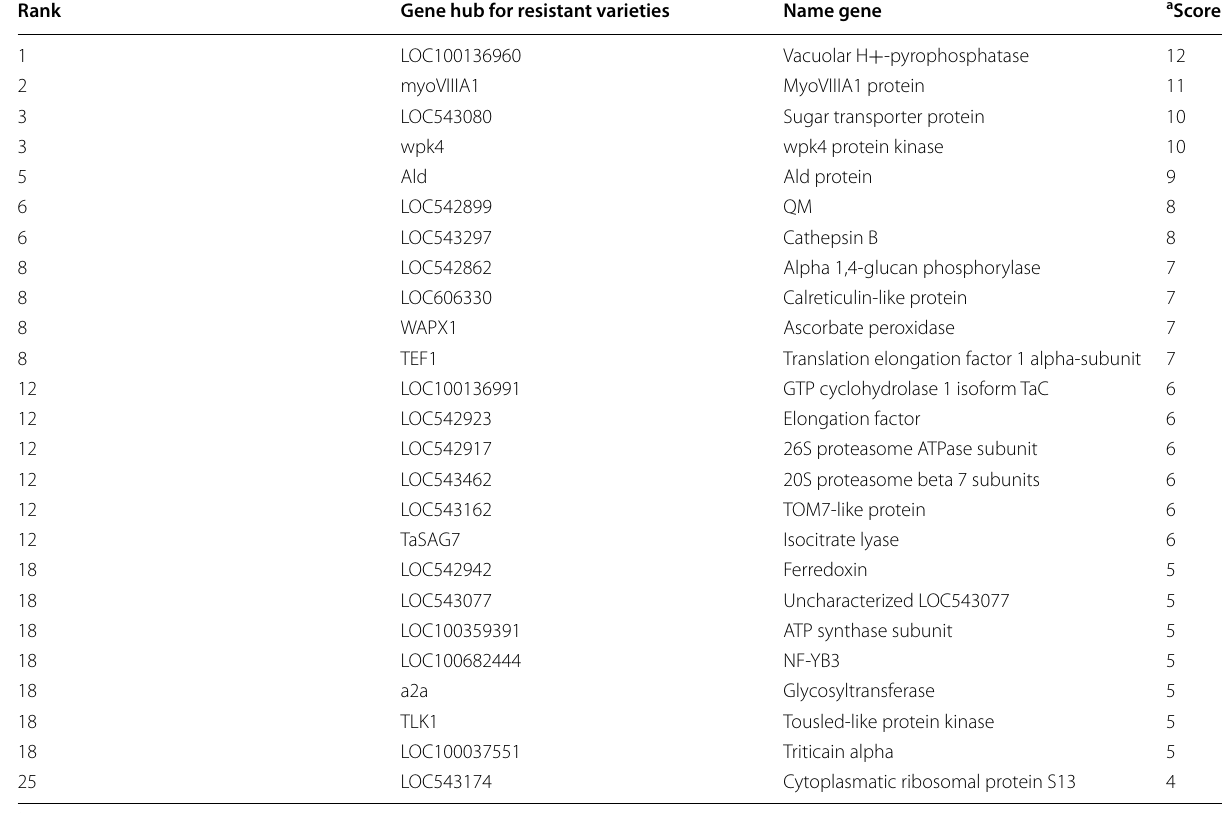
Table 5 Hub genes identified for resistant varieties